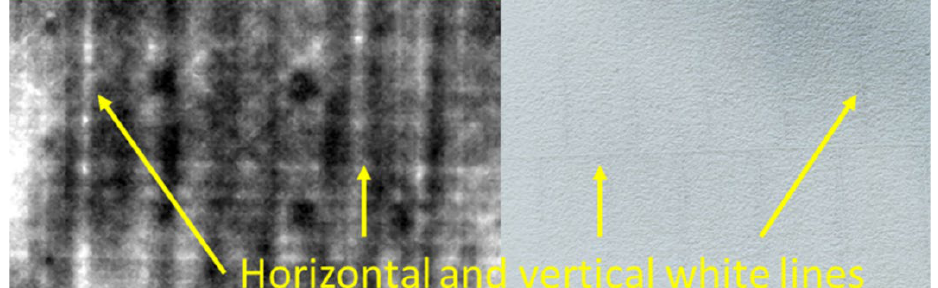
Figure 6. IR image of the canals located in the PET foam core. Table 5. Distances between equipment.